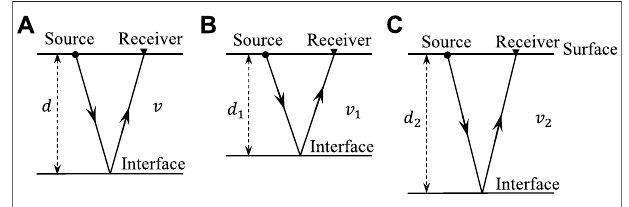
FIGURE 1 | Schematic illustration for the trade-off between the depth of interfaceandvelocityaboveit. (A) Thetruescenario:bothdepth d andvelocity v are correct. (B) The trade-off scenario 1: d 1 < d , v 1 < v . (C) The trade-off scenario 2: d 2 > d , v 2 > v . The two trade-off scenarios give the same travel time as the true